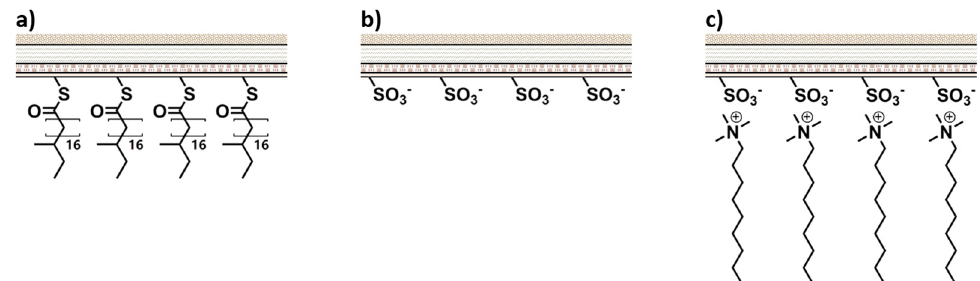
Figure 7. Repairing action of cationic conditioners: ( a ) undamaged hair covered with its natural hydrophobic protective F ‐ layer; ( b ) negatively charge damaged hair without the F ‐ layer; ( c ) hair repaired with conditioner, the cationic surfactant adsorbs to the surface. Adapted from reference [44] with permission from Elsevier.